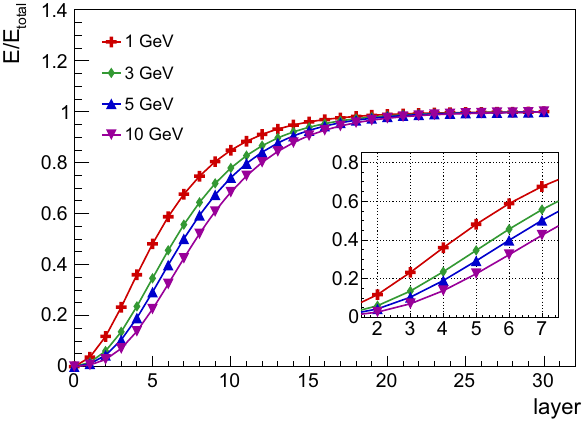
Fig. 25 Normalised longitudinal shower profile for different electron energiesobtainedinsimulation.Highlightedregioncorrespondstosen- sitive layers installed in the calorimeter. The inset shows the same pro- files in a logarithmic scale